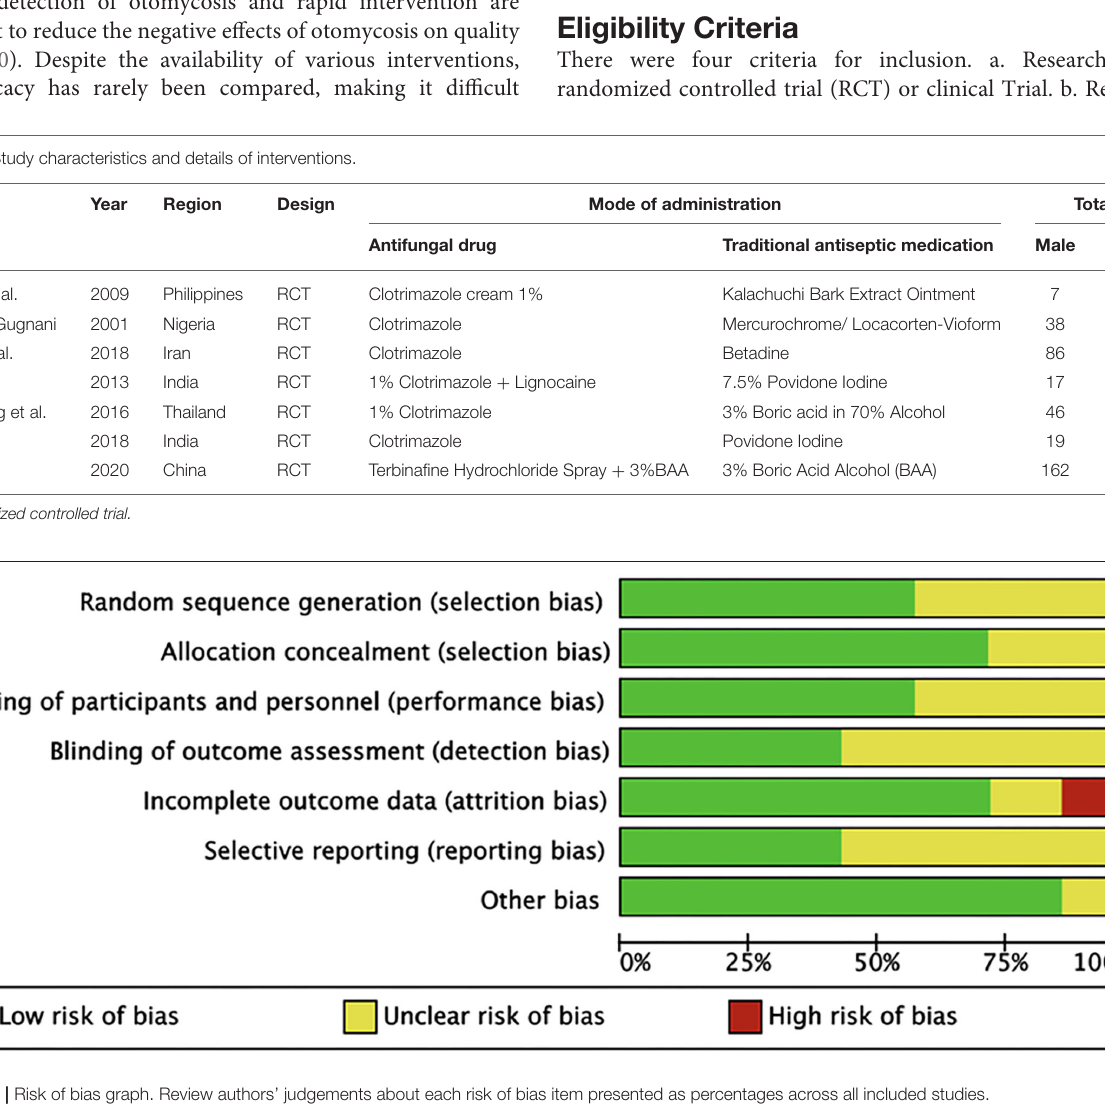
Frontiers in Surgery |